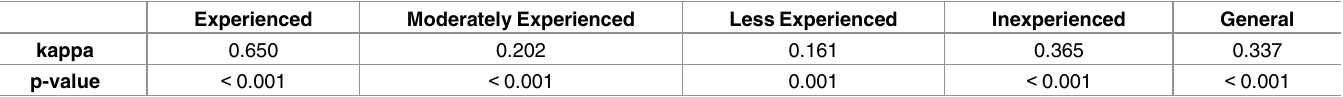
Table 6. Kappa coefficients of agreement among the five experts in each category classification and the model’s categories, and the general agreementof all classifications of running experience in the real dataset (n = 100).